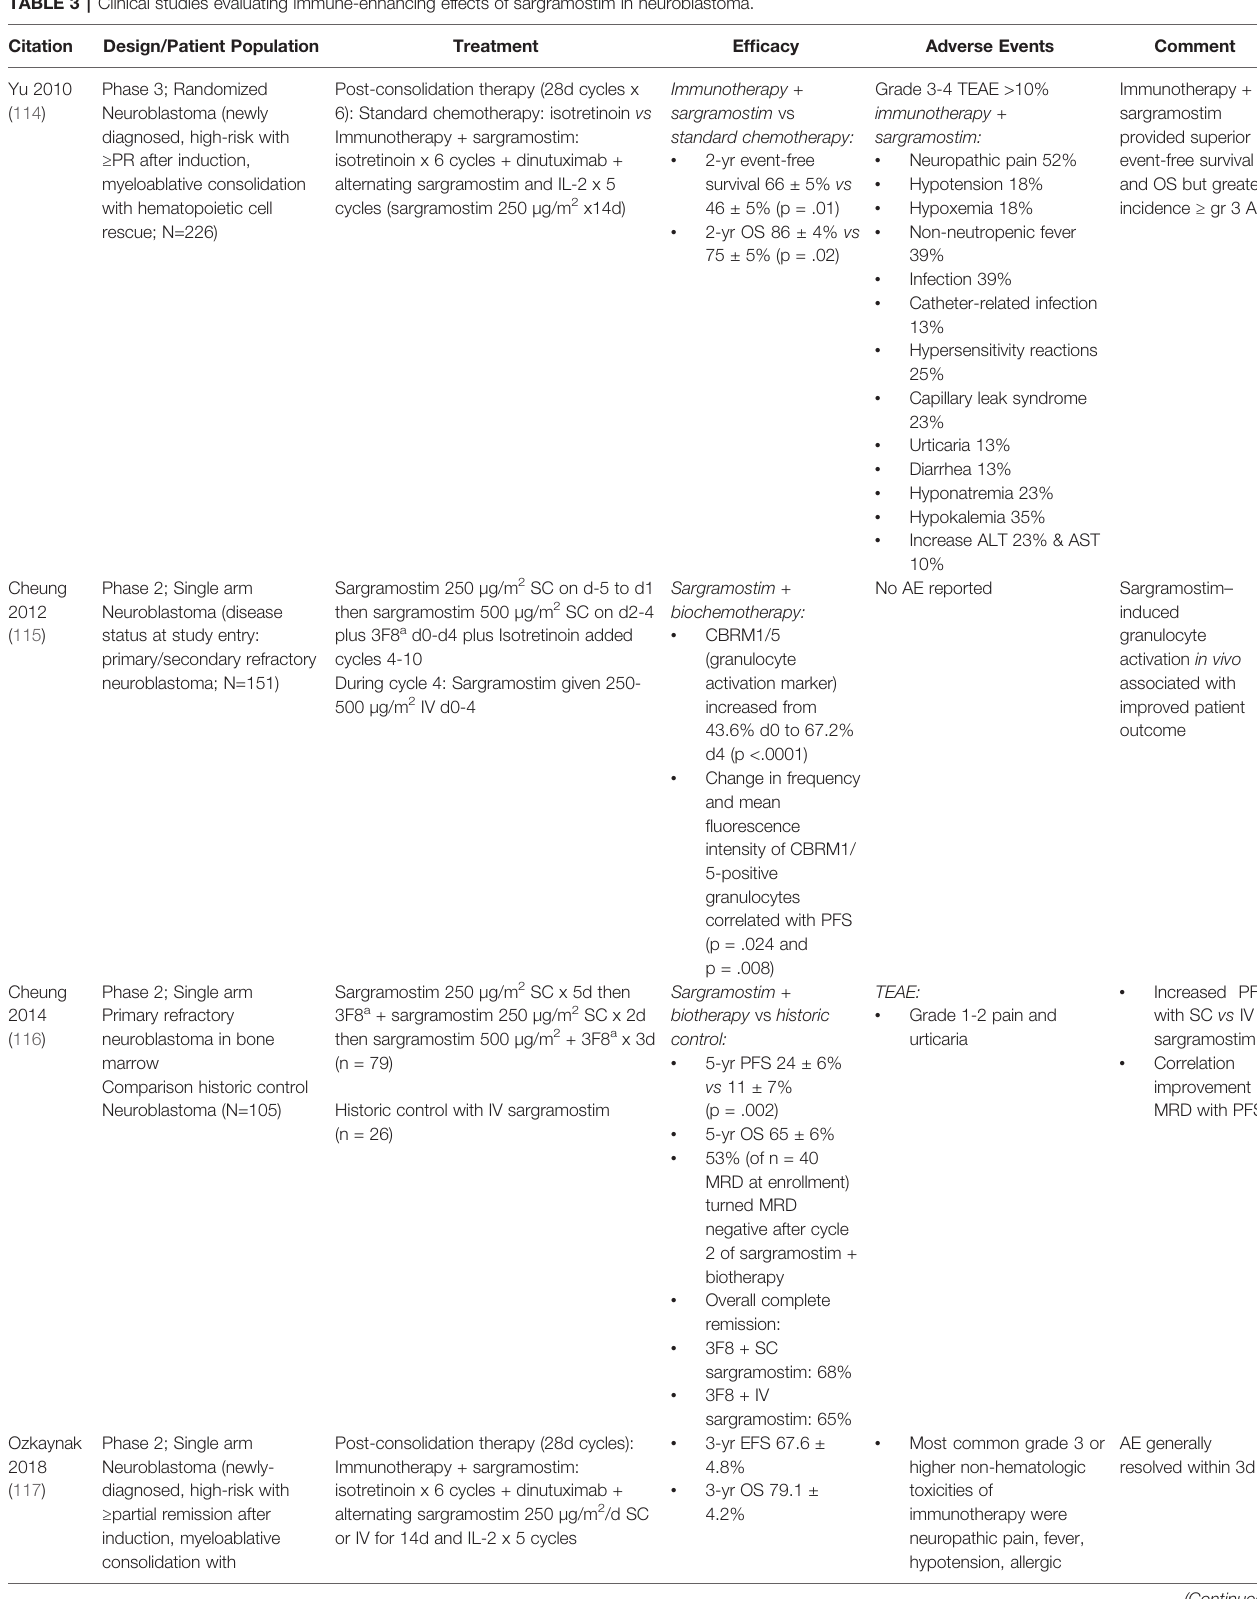
TABLE 3 | Clinical studies evaluating immune-enhancing effects of sargramostim in neuroblastoma. Citation